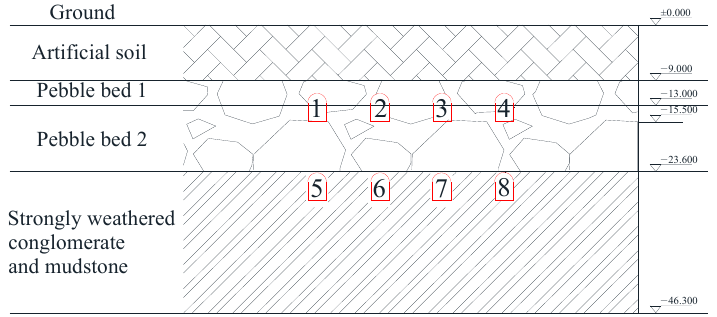
Figure 3. Positions of the tunnels relative to one another.